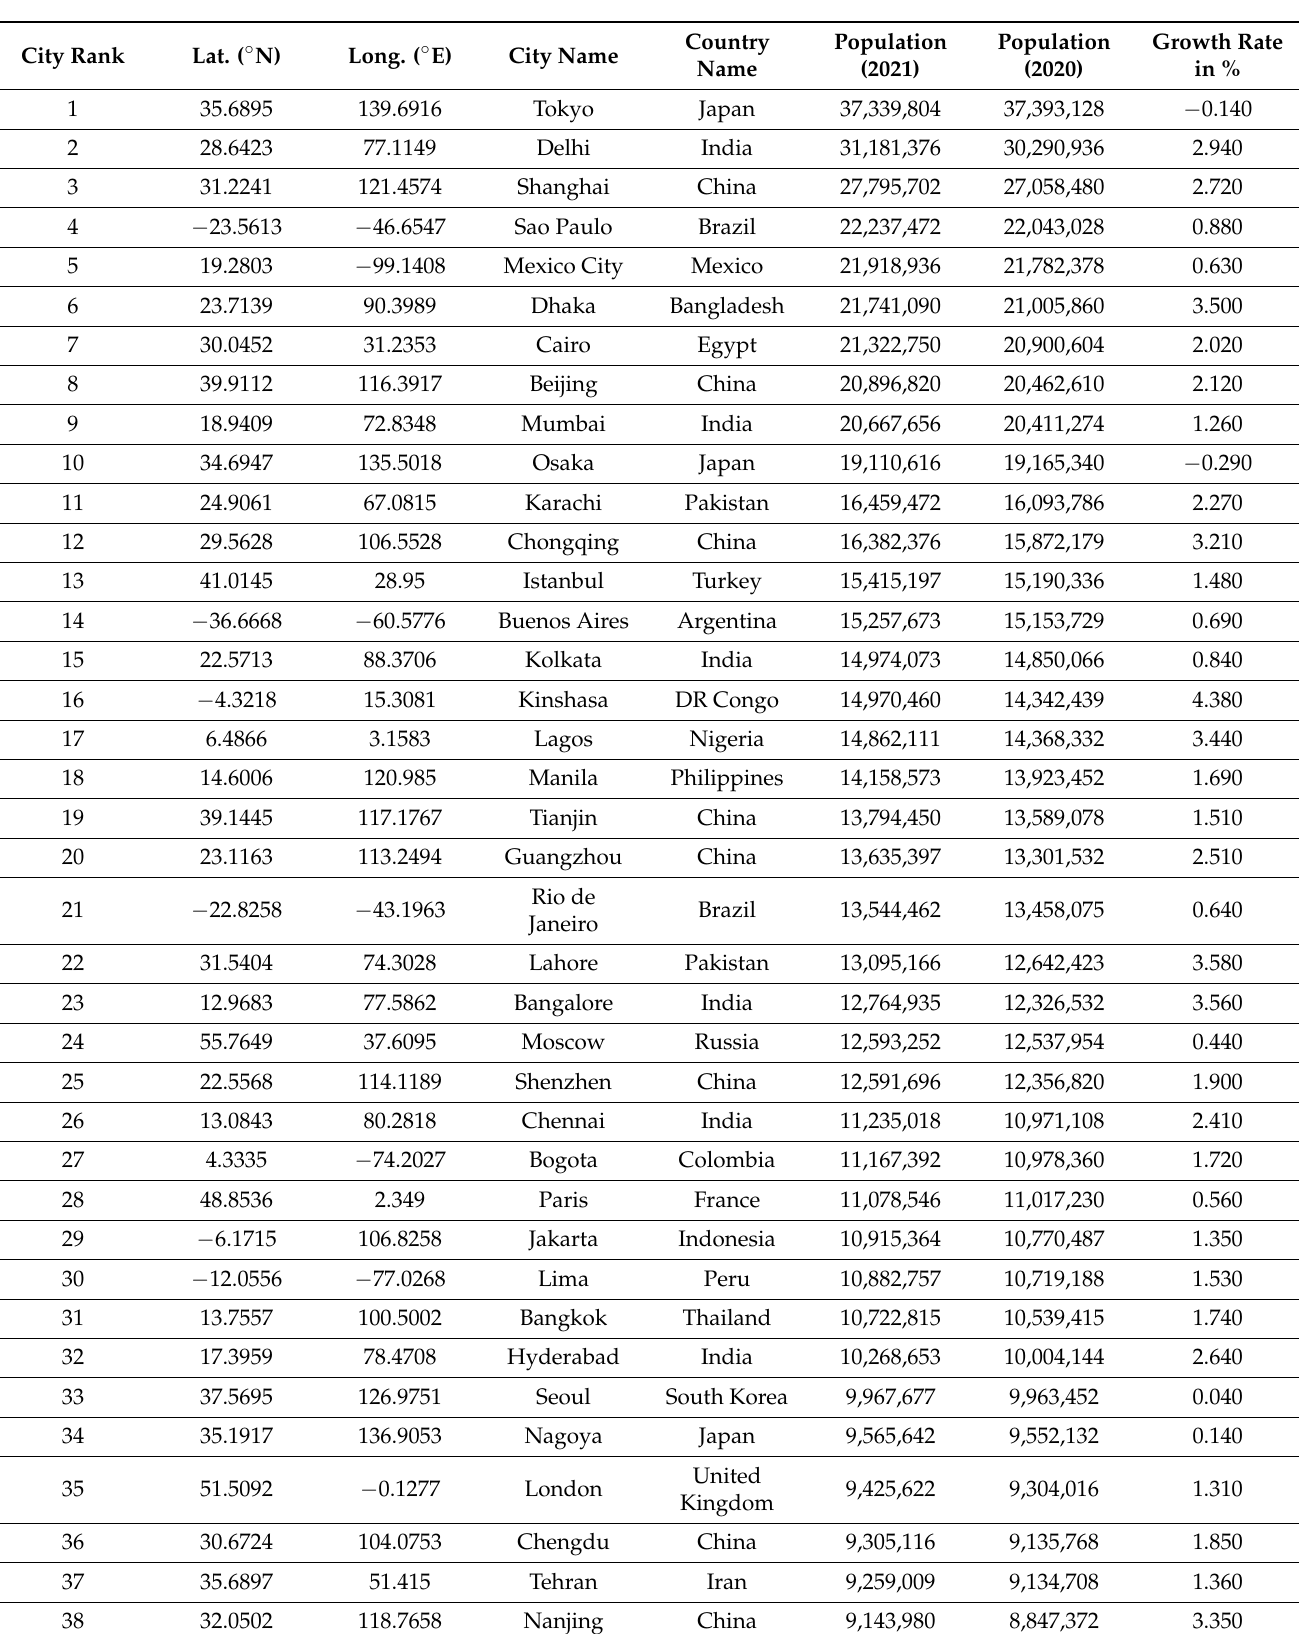
Table 1. Rank of cities showing increasing and decreasing population growth rate concerning different latitude and longitude between city centers of different